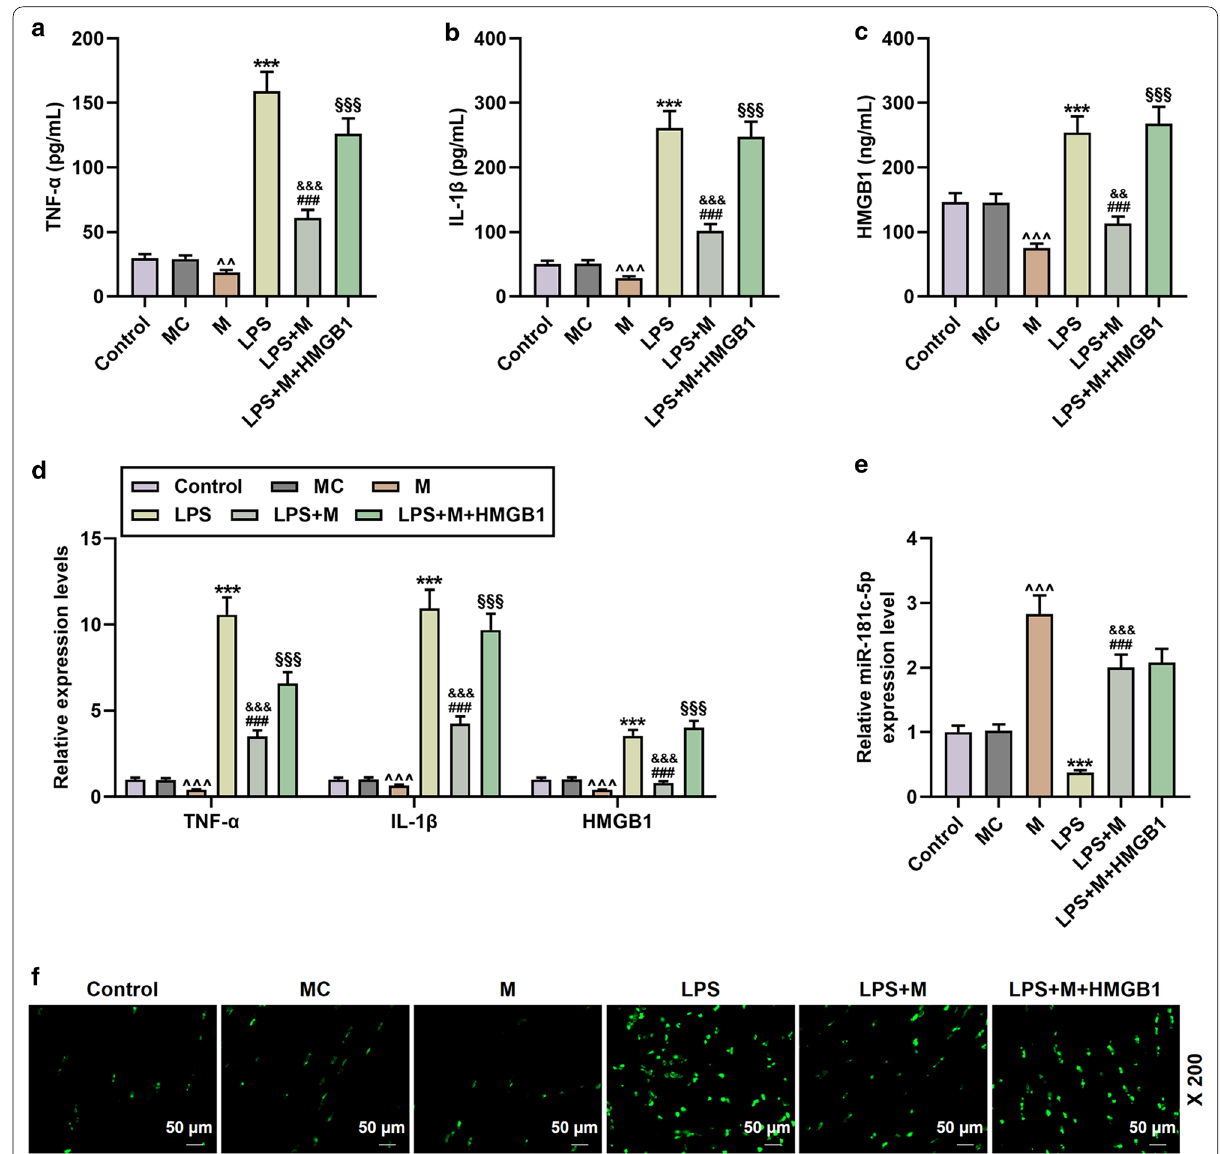
Fig. 4 The effect of miR-181c-5p on cytokines and apoptosis in microglia. a – d The contents and mRNA levels of TNF-α, IL-1β, and HMGB1 in the Control, MC, M, LPS, LPS M, LPS M HMGB1 groups were determined by ELISA and qRT-PCR, respectively. N + + + vs Control; ^^ P < 0.01, ^^^ P < 0.001 vs MC; && P < 0.01, &&& P < 0.001 vs M; ### P < 0.001 vs LPS; §§§ P < 0.001 vs LPS